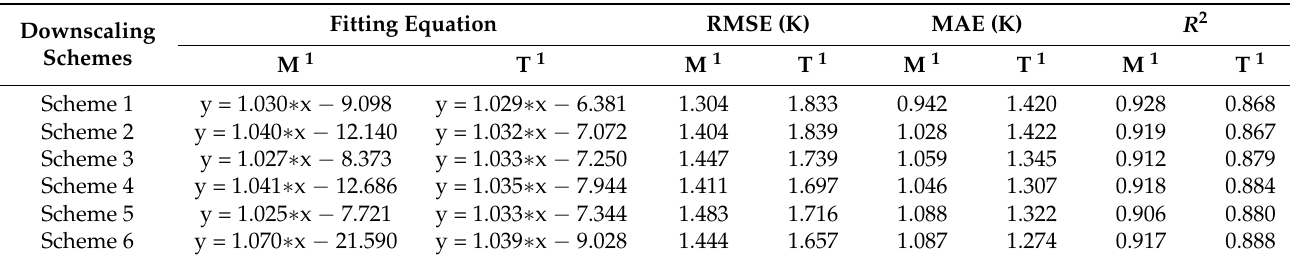
Figure 6. Spatial distribution of the water-masked LST (K) data. ( a1 ) Retrieved 30 m LST (K) data, ( a2 ) MFGWML downscaled 10 m LST (K) data, and ( a3 ) thermal image sharpening (TsHARP) downscaled 10 m LST (K) data. Plots ( b1 – b3 ) are the corresponding subsets of plots ( a1 – a3 ), respectively. The black rectangle is the minimum bounding rectangle of the central urban area; it represents the spatial extent of the subset. The blanks in these plots denote no-data areas due to the exclusion of water regions. Table 6. Statistical parameters of the fitting lines for scatters in MFGWML and TsHARP for the six downscaling schemes performed in the entire Beijing (excluding water